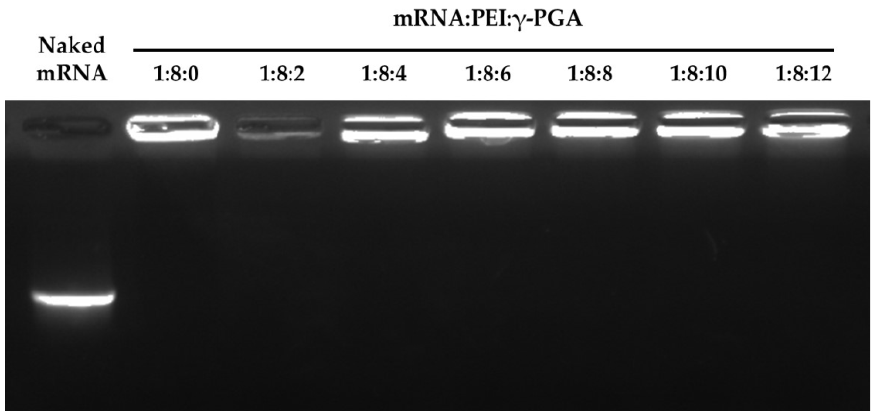
Figure 3. Electrophoretic analysis of the mRNA/PEI8/ γ -PGA complexes. The complexes were applied to an agarose gel and subjected to electrophoresis. Retardation of the mRNA was visualized using GelRed.